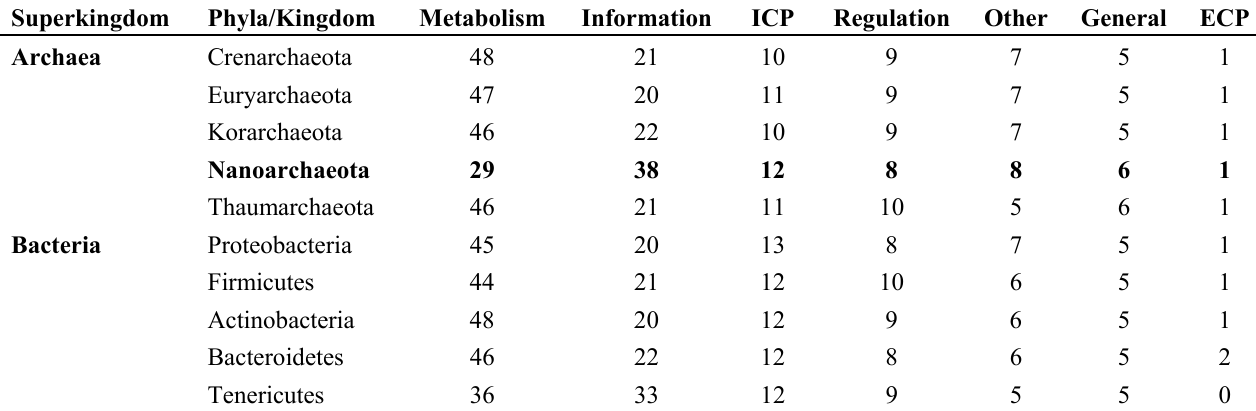
Table S2. Average percentage of FSF domains in each phyla/kingdom corresponding to the seven general functional categories. Numbers were rounded up when the decimal value exceeded 0.5 and rounded down otherwise. Nanoarchaeota (highlighted in bold) is an outlier considering it has the smallest percentage for metabolic domains compared to the rest and this decrease is offset by an increase in the informational